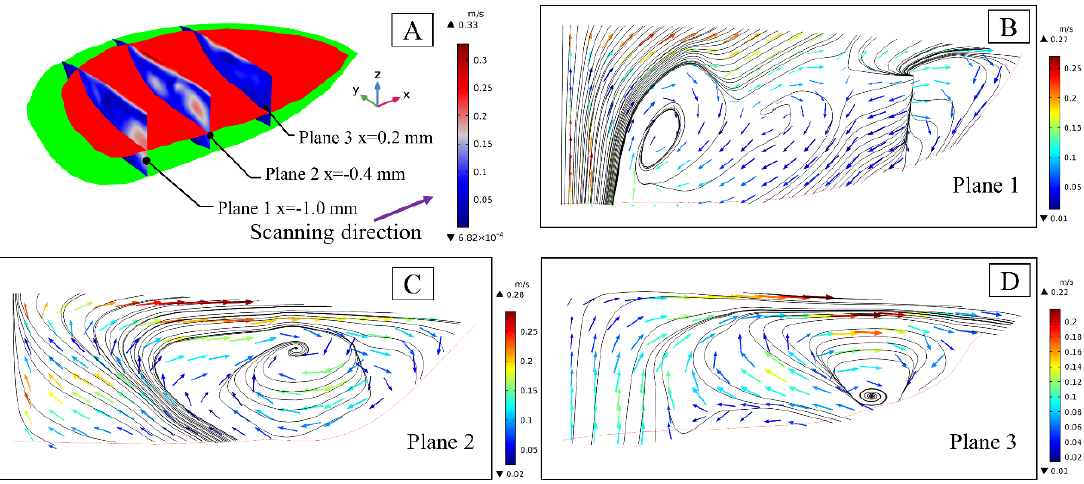
Figure 8. Melt pool profile, cross-section coordinates and velocity distribution on yz-plane. ( A ) Melt pool configuration and position of three yz-sections; ( B ) Velocity distribution at plane 1; ( C ) Velocity distribution at plane 2; ( D ) Velocity distribution at plane 3.